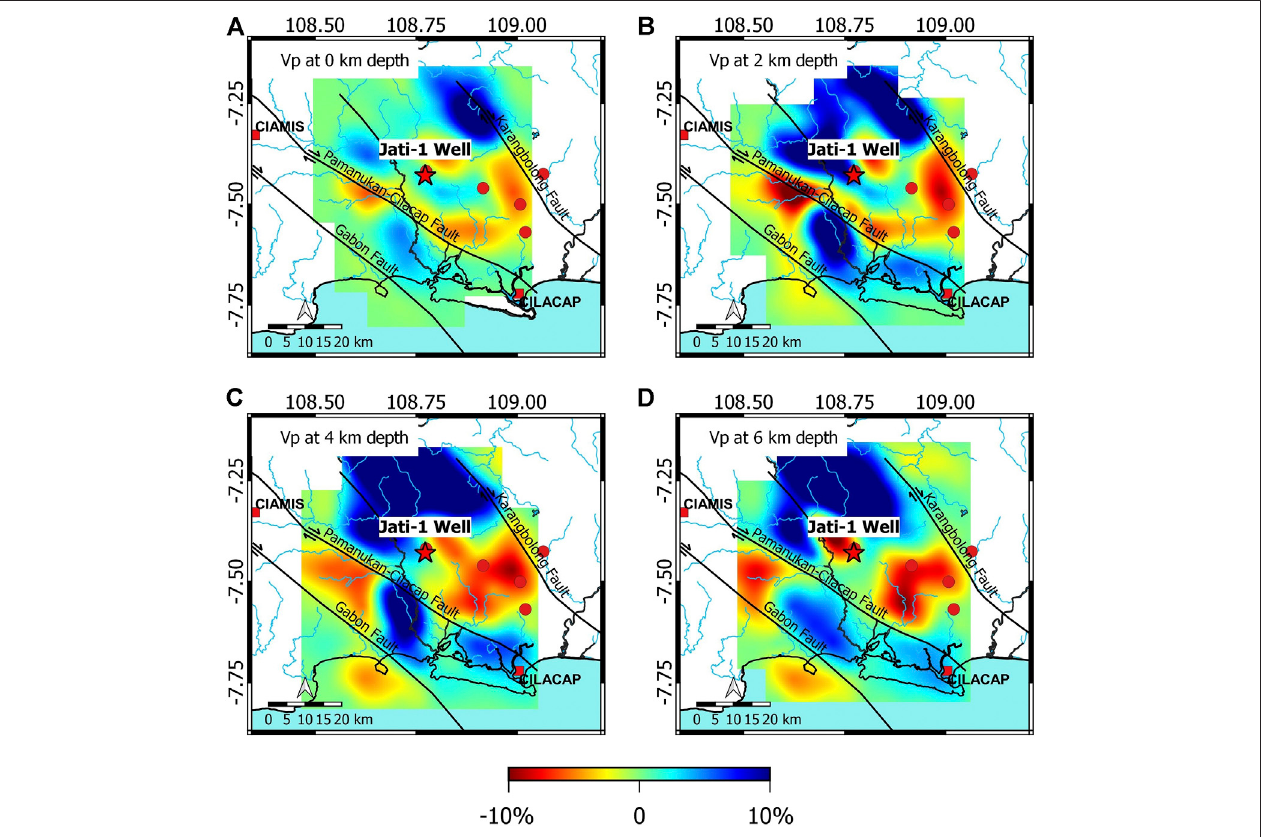
FIGURE 7 | Horizontal cross section results of % velocity perturbation relative to the initial 1-D velocity model for: (A) 0 km depth, (B) 2 km depth, (C) 4 km depth, and (D) 6 km depth. Jati-1 well location is shown by a red star, while oil seepage discoveries are shown by red circles. The low-velocity anomaly, shown by red color, con fi rmed a low gravity anomaly ( Figure 6A ) and interpreted as possible subbasins around the study area. The Miocene geological structure of Figure 6B was overlaid over the Vp horizontal cross sections map.